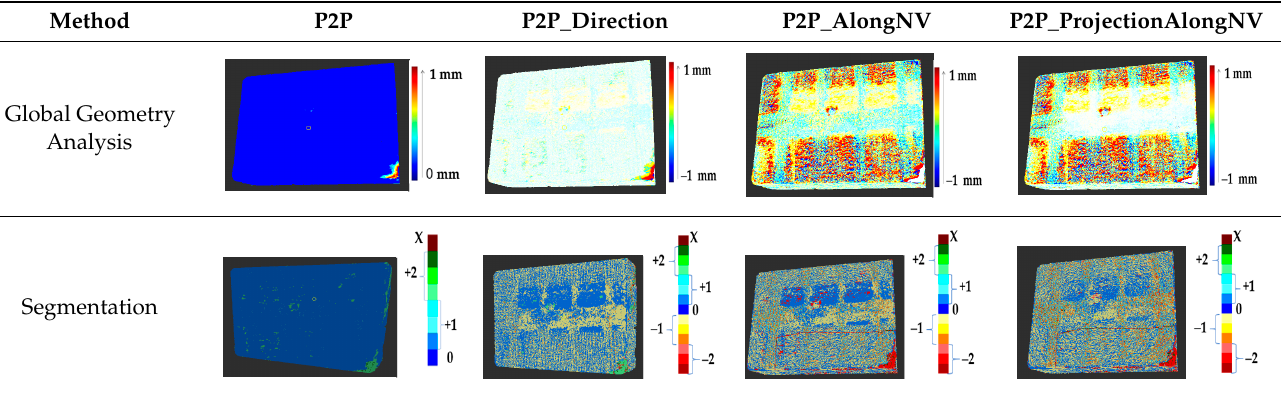
Table 15. Analysis and results for the dataset of NGL2.